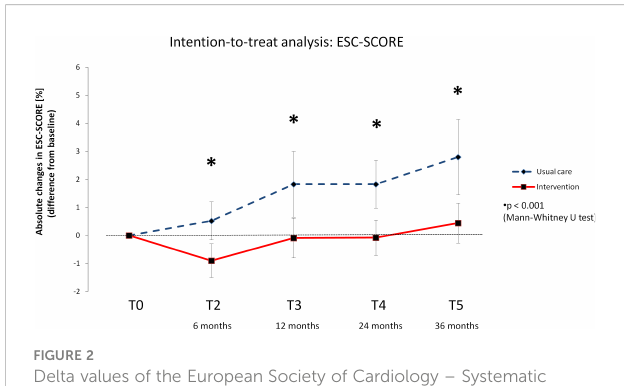
FIGURE 2 Delta values of the European Society of Cardiology – Systematic Coronary Risk Evaluation score (ESC-SCORE) – Intention-to-treat analysis. Means with 95% con fi dence